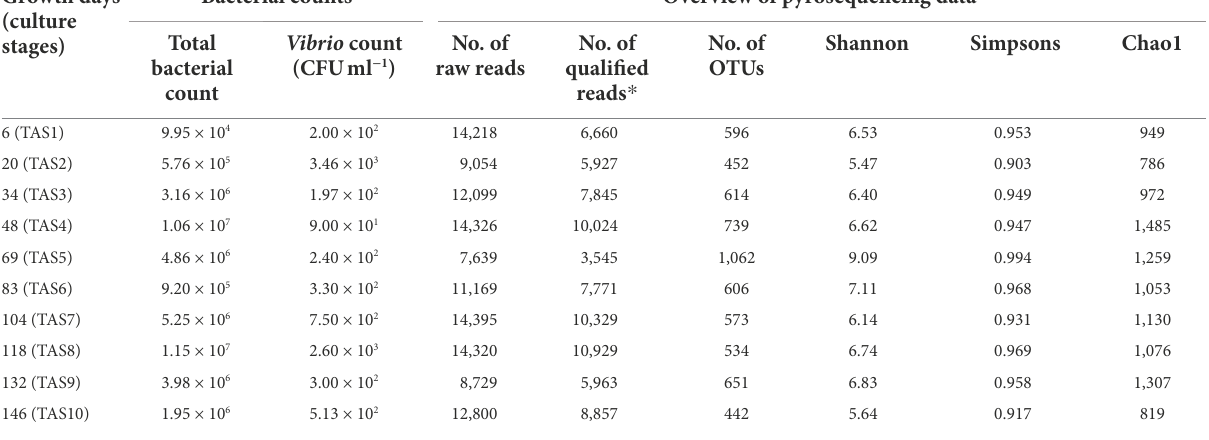
TABLE 2 Total bacterial counts, Vibrio spp. counts and pyrosequencing output of rearing water. Growth days